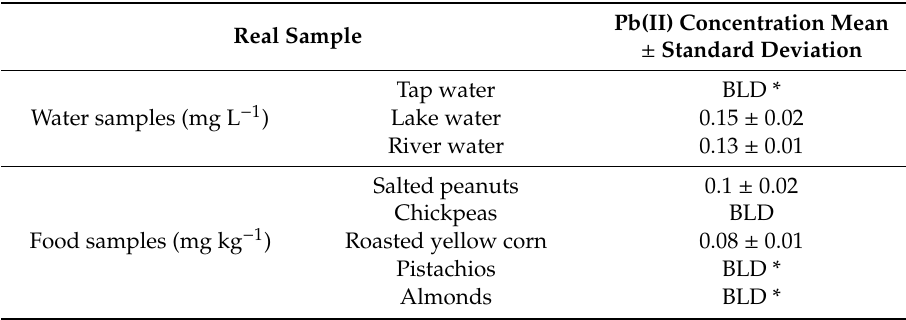
Table 3. Determination of Pb(II) in samples from water and food extracts ( n =